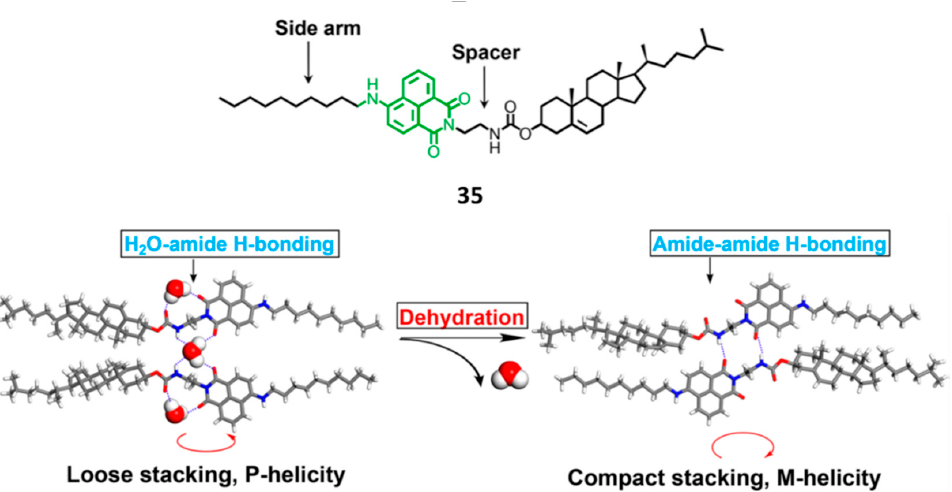
Figure 25. Chemical structure of compound 35 and proposed mechanism of dehydration-induced chirality inversion. Adapted with permission from ACS [58].